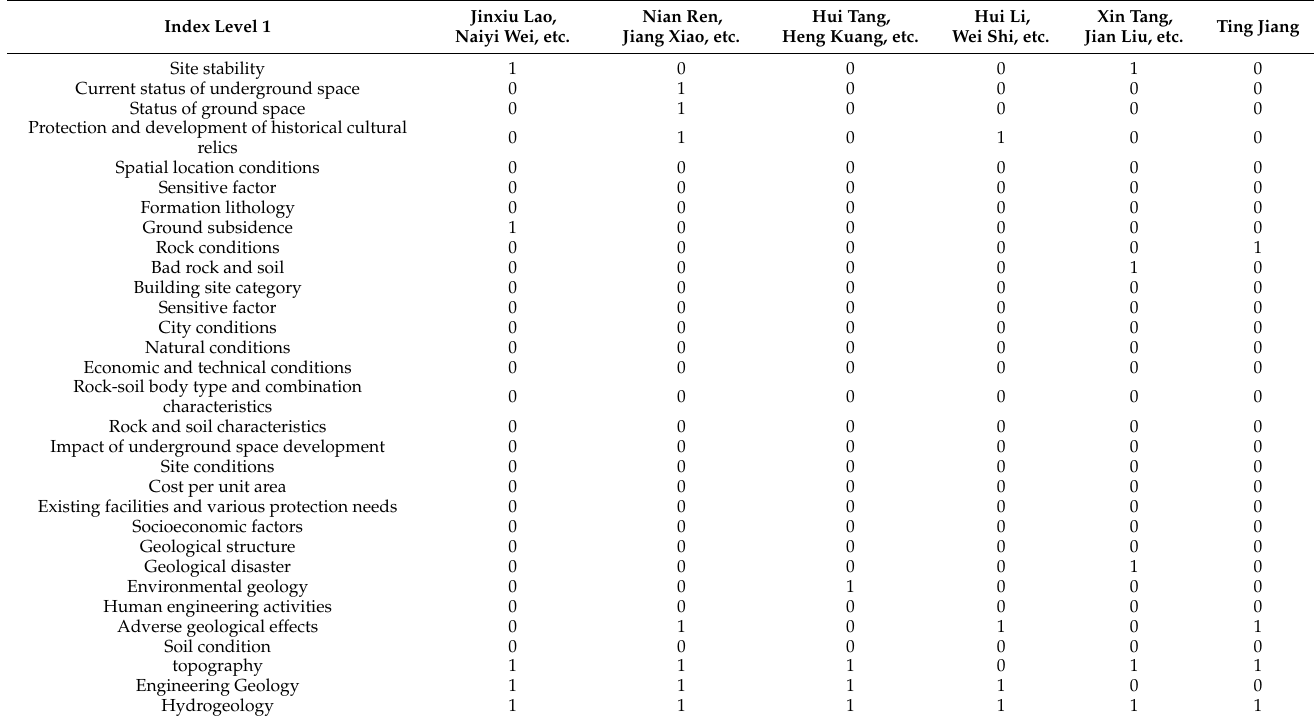
Table A3. First level index binarization